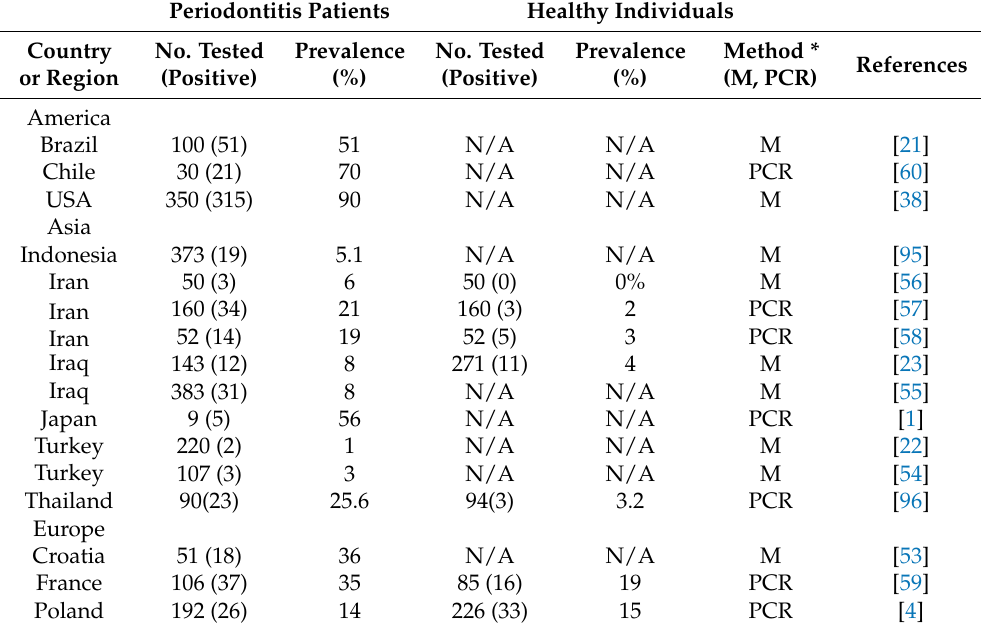
Table 4. Prevalence of Trichomonas tenax in humans with or without